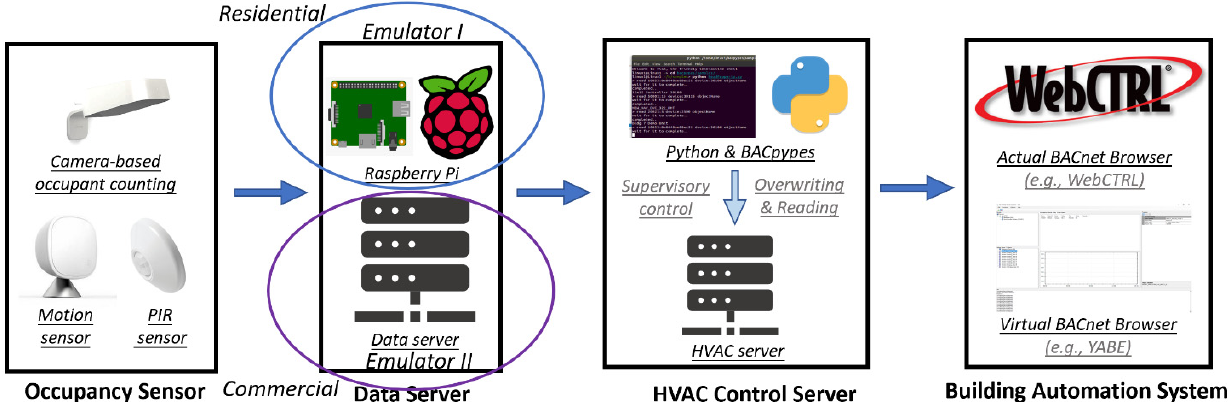
Figure 2. The whole process of the emulator.